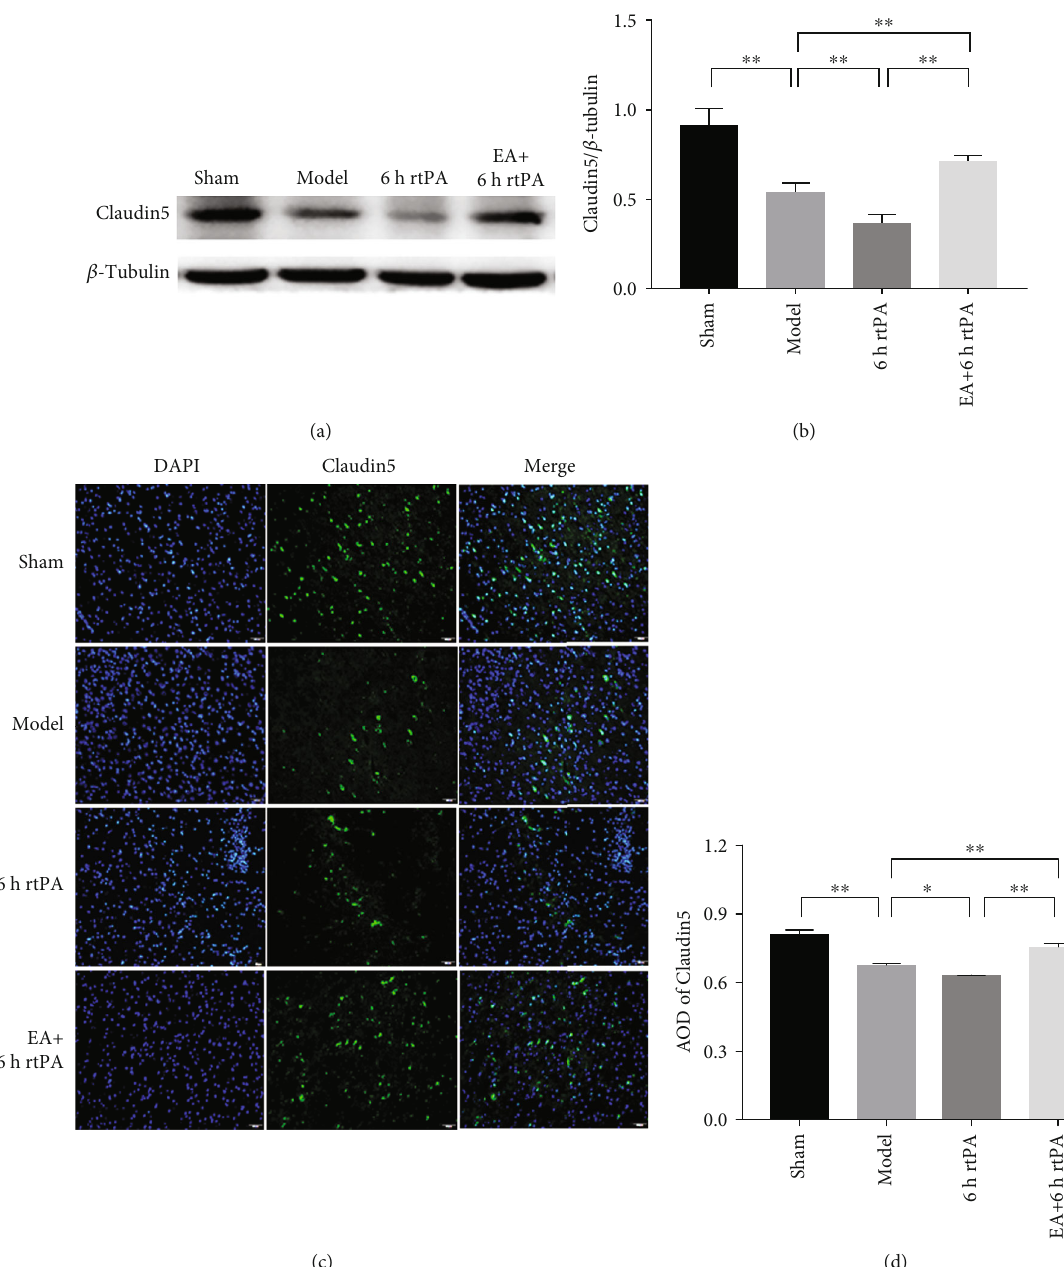
Figure 5: Western blot and immuno fl uorescence staining for Claudin5 in each group ( n = 6 rats). (a) Representative immunoblot showing Claudin5 levels in the ischemic penumbra area. (b) Relative levels of the Claudin5 protein. (c) Representative images of Claudin5 staining in the ischemic penumbra area. Bar = 50 μ m . (d) Average optical density of Claudin 5. ∗ indicates p < 0 : 05 ; ∗∗ indicates p < 0 : 01